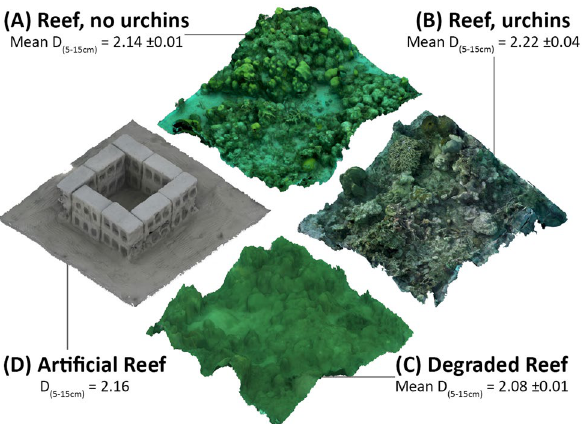
Figure 2. Three-dimensional images showing complexity differences between: ( A ) a 2 m × 2 m area of reef without urchins on Utila, ( B ) a 2 m × 2 m area of reef with urchins on Utila, ( C ) a 2 m × 2 m area of control reef in La Ensenada, ( D ) an artificial reef deployed at La Ensenada. D (5–15 cm) = fractal dimension of the model at the 5–15 cm spatial resolution. Mean ± 1SE is reported for ( A )–( C ), but all artificial reefs are identical therefore variation in fractal dimension for (D) is not